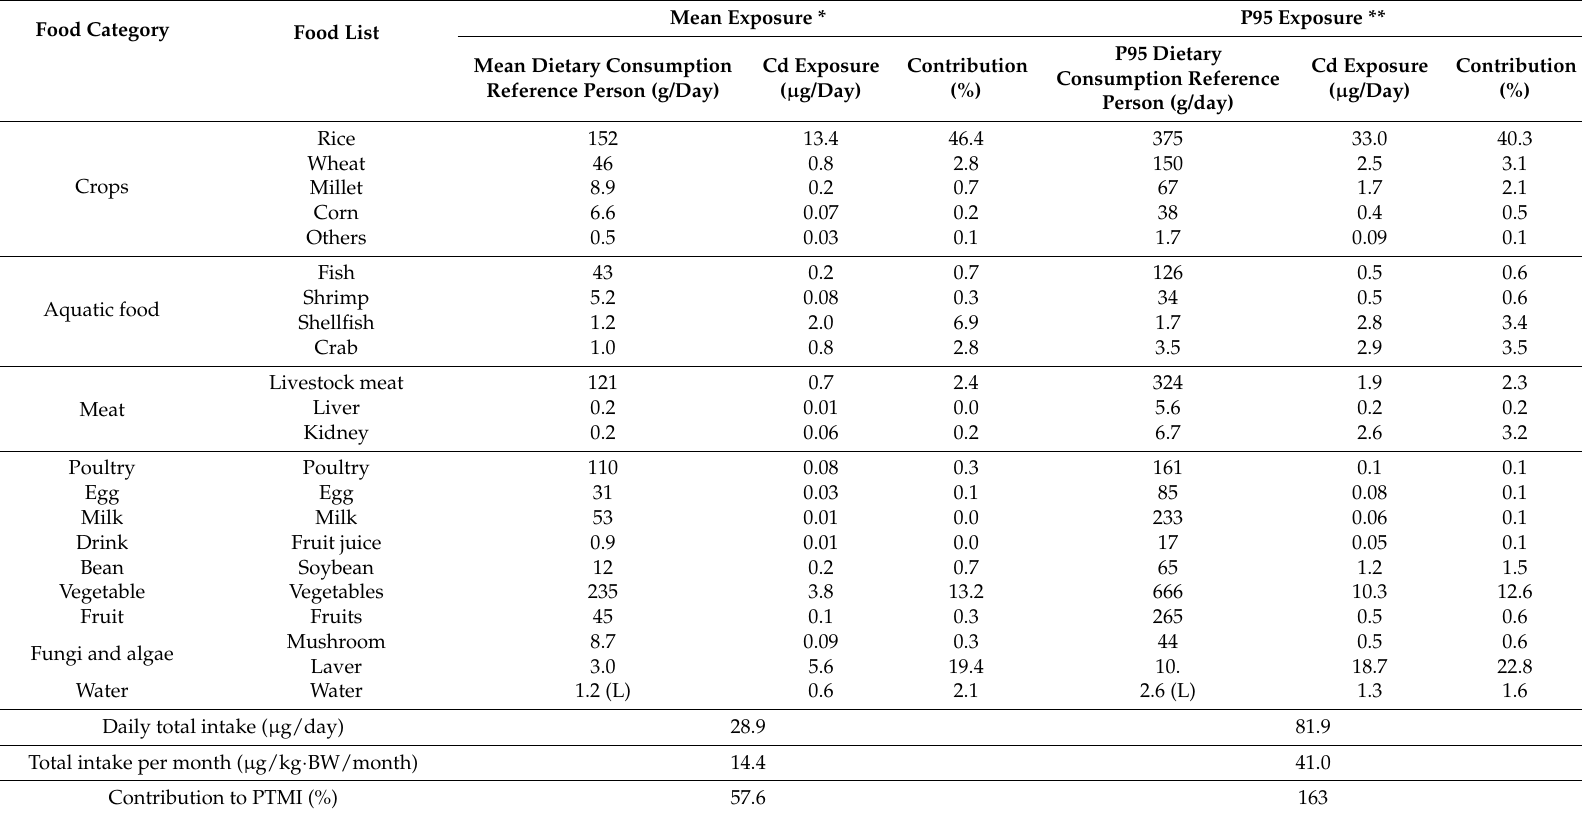
Table 2. Dietary cadmium (Cd) exposure in Guangzhou